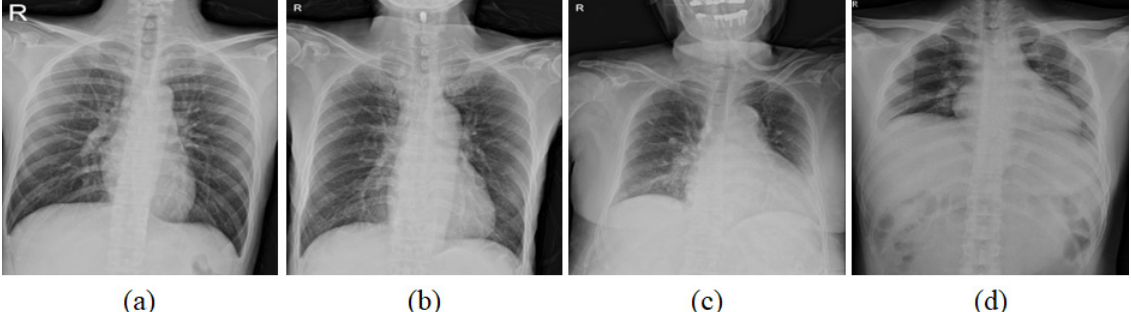
Figure 2. With the same density score as zero annotated by physician, mean intensities of lungs in CXRs are ( a ) 39.8, ( b ) 34.4, ( c ) 16.6, and ( d ) 13.2, respectively.